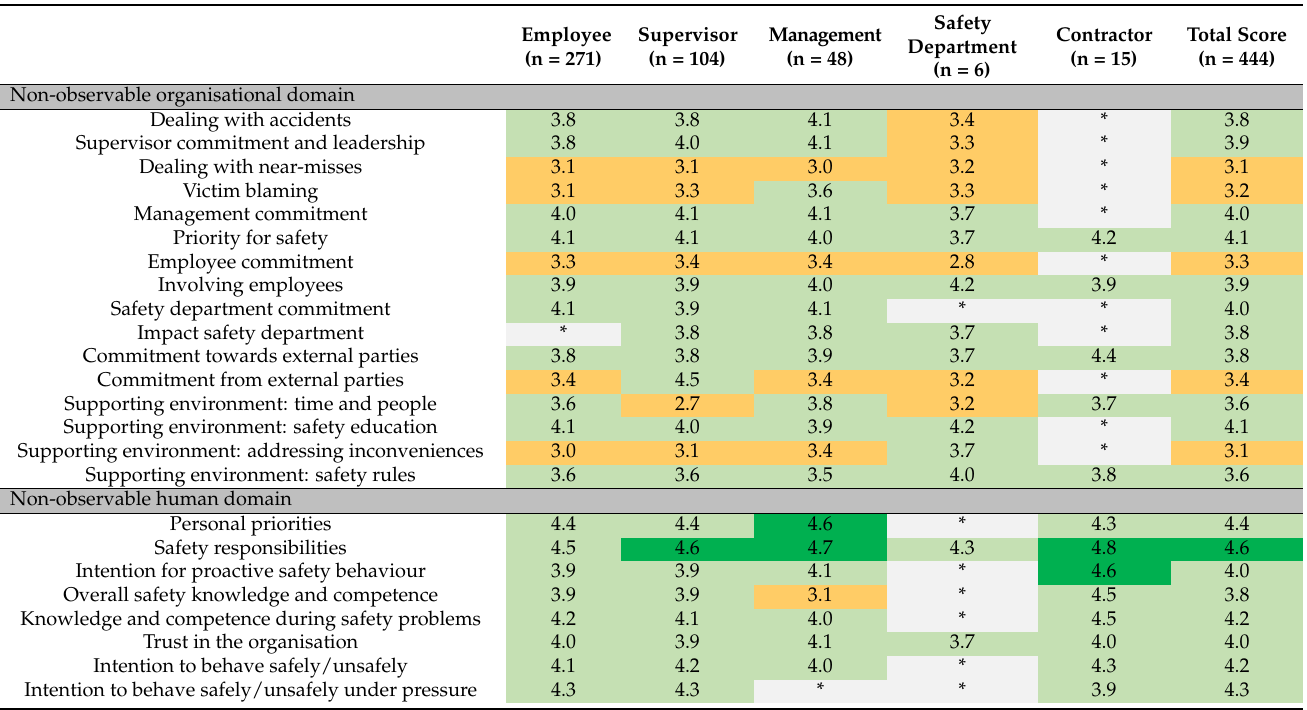
Table 10. Example of sub-domain results per position (Score from 1 to 5).